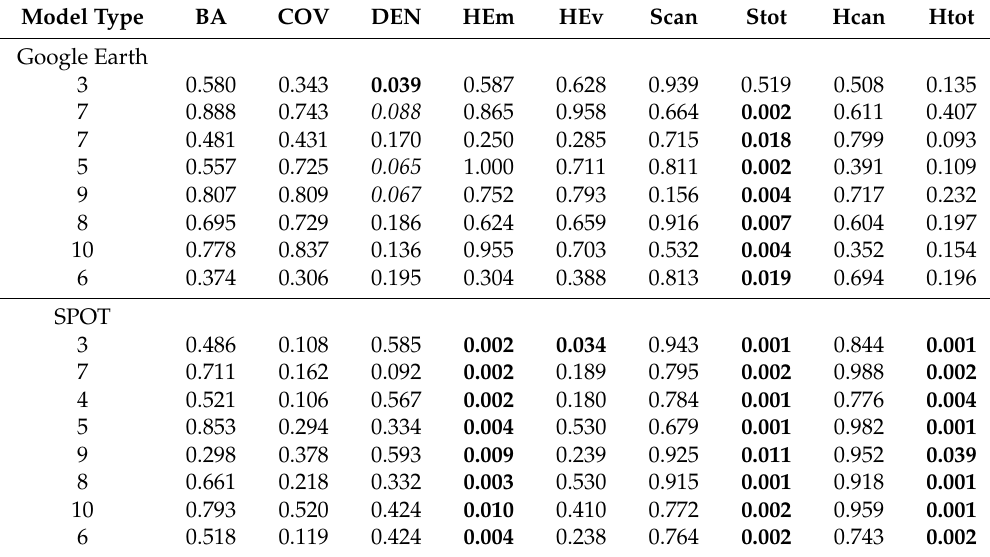
Table 1. P -values of the R 2 ’s associated with the best model (selected through AICc) for each vegetation variable, image, and model type (following equation numbers in text). Bold typeface, P < 0.05; italics, P < 0.1. BA, basal area; COV, vegetation cover; DEN, density of individuals; HEm, mean